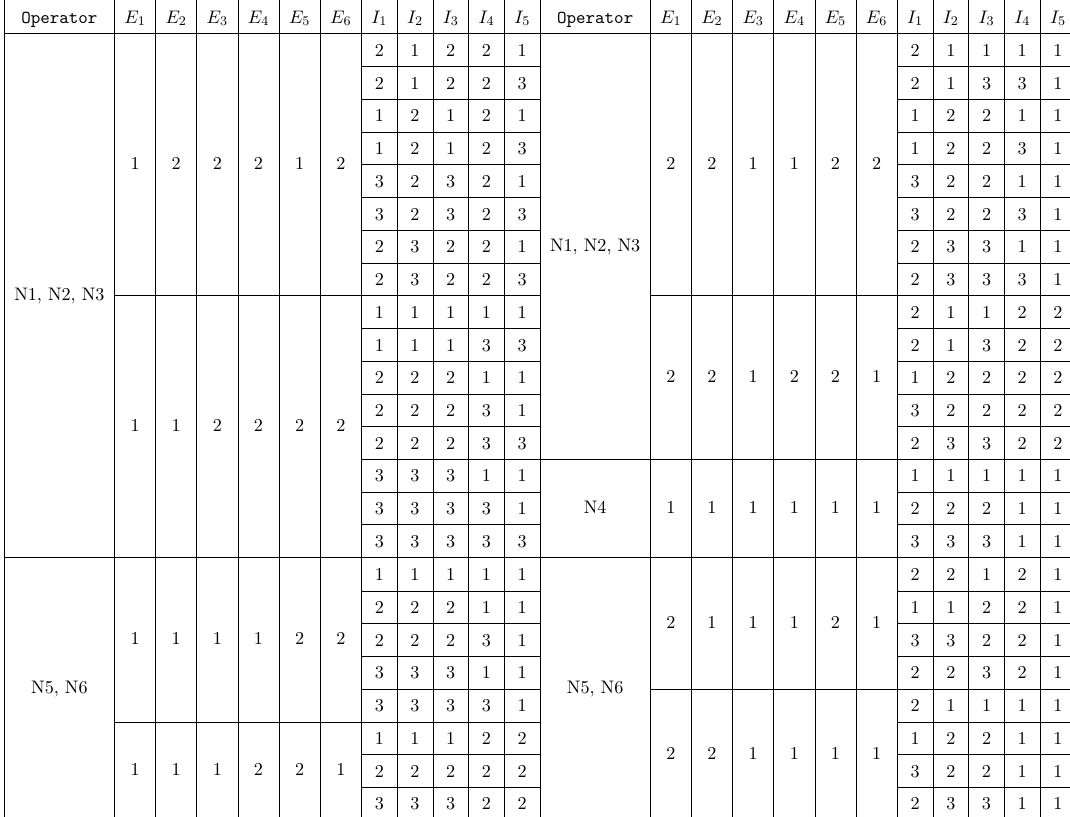
Table 2 . Assign the SU(2) L quantum numbers to fields of the topology N-1-1 in figure 1.